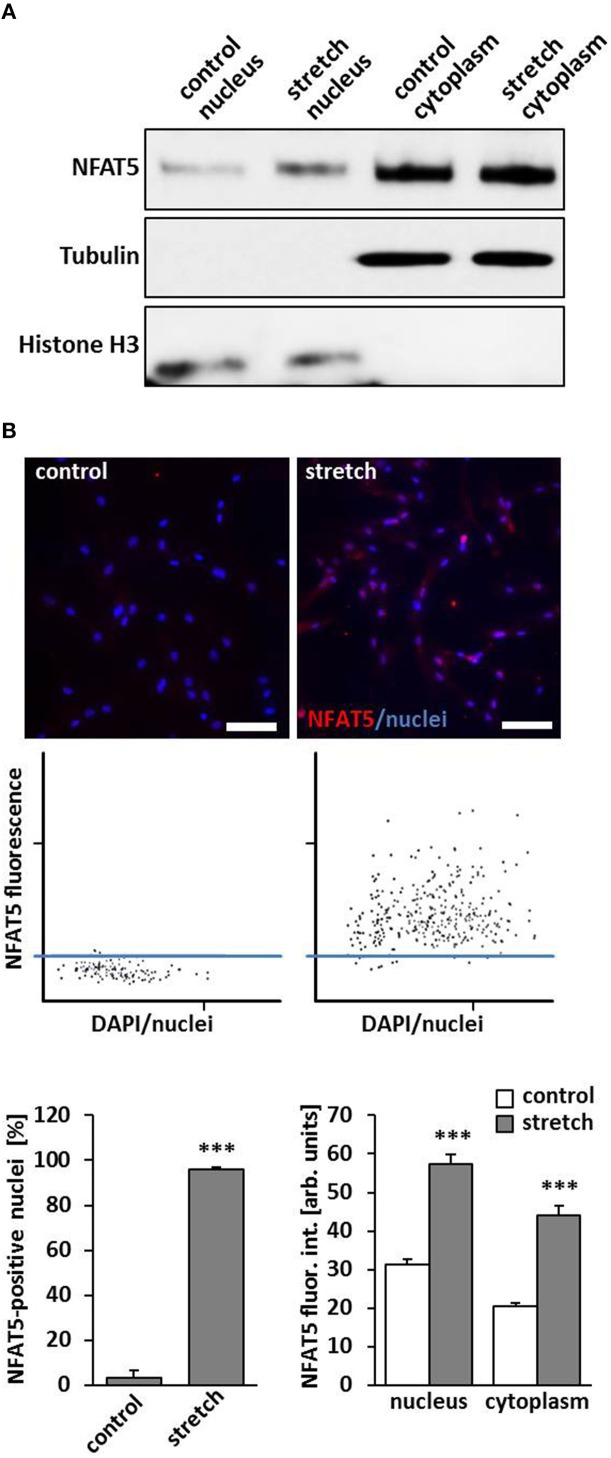
Biomechanical stretch induces nuclear translocation of Nuclear factor of activated T cells 5 (NFAT5). HUASMCs were exposed to biomechanical stretch for 24 h. Subsequent Western blot analyses of nuclear and cytosolic protein fractions showed an increase of nuclear NFAT5 abundance compared to control conditions (A). Automated immunofluorescence analyses (TissueGnostics/TissueQuest) revealed a significant increase of NFAT5 positive nuclei (B, ***p < 0.001 vs. control, n = 3) and NFAT5-specific nuclear/cytoplasmic fluorescence intensity (B, ***p < 0.001 vs. control, n = 3) in stretch-stimulated VSMCs which is also demonstrated by corresponding scattergramms. The threshold was set according to the basal NFAT5 fluorescence intensity under control conditions (scale bar: 100 μm).